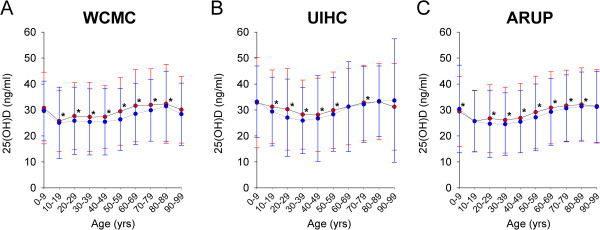
25(OH)D immunoassay – average concentration by age and sex – results by decade of life. A,B. Average 25(OH)D results at WCMC (A), UIHC (B), and ARUP (C) by age (in 10 year bins) and sex [female = red circles; male = blue circles]. Error bars are ± SD. * p < 0.05.